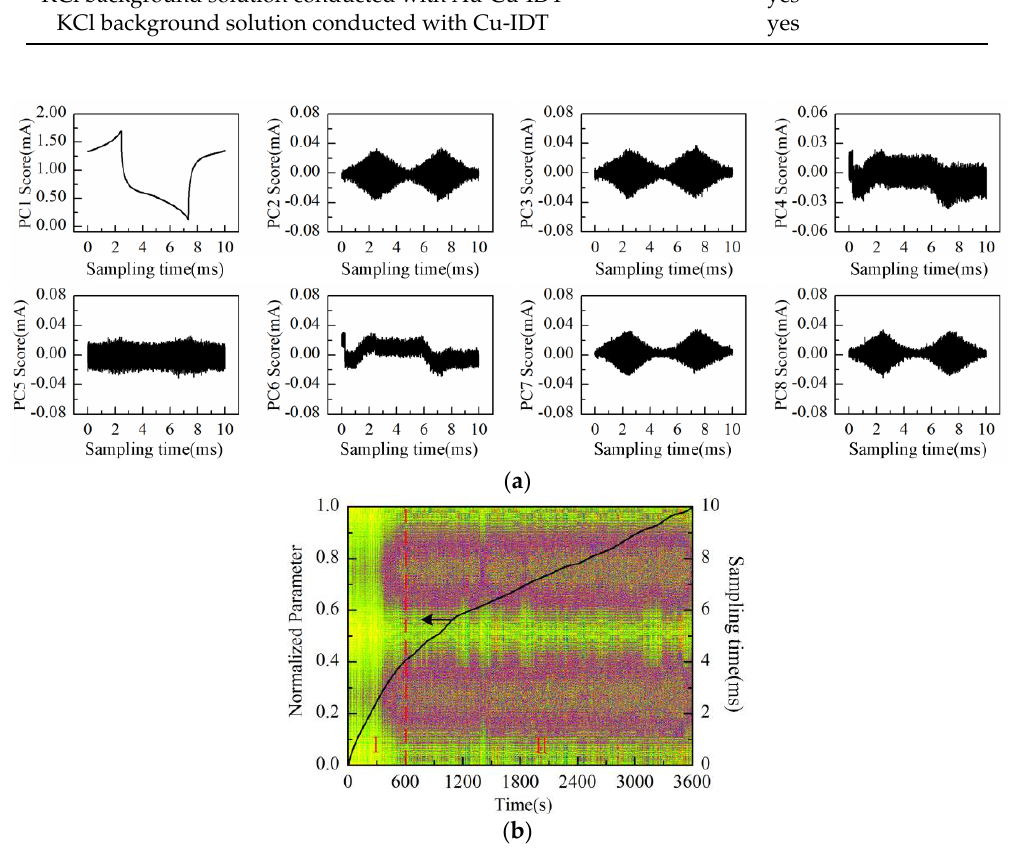
Figure 13. Measurement results of the KCl background solution conducted with Cu-IDT: ( a ) PC1–PC8 scores plot; ( b ) PC1 loading curve (after SSA) and the reconstructed noise image.